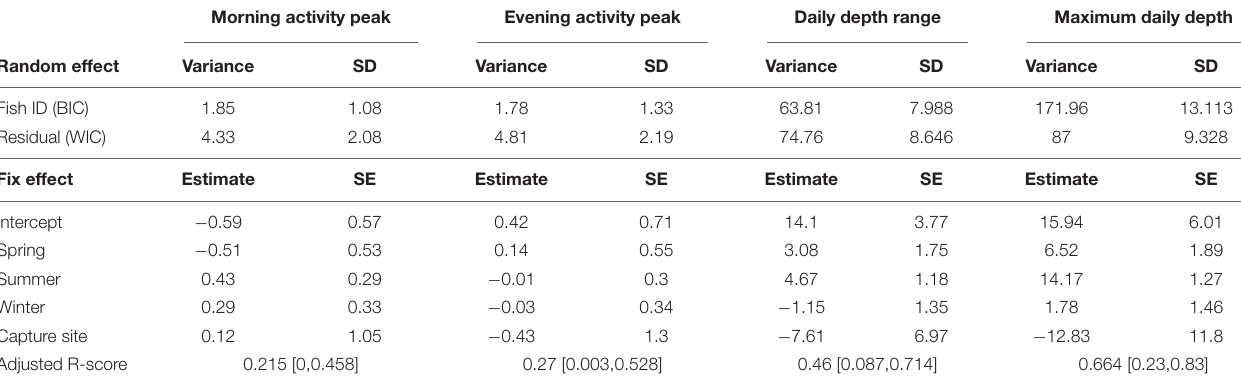
TABLE 3 | Mixed effect model results including adjusted R-score, between-individual (BIC), and within-individual variation (WIC) for the daily indices (morning activity peak, evening activity peak, daily depth range, and maximum daily